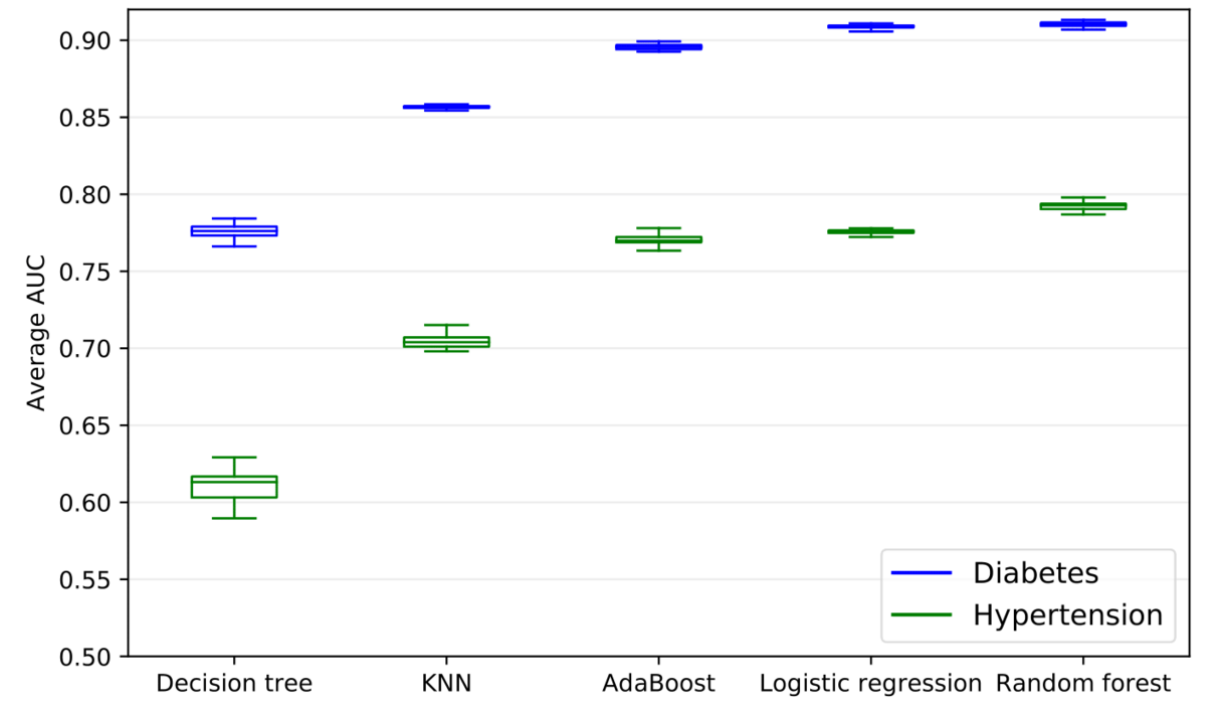
Figure 1. A comparison of area under the curve (AUC) distributions across 250 test sets between 5 risk stratification models for both diabetes and hypertension. The random forest model had the highest AUC for both diabetes (mean [SD], 0.910 [0.001]) and hypertension (mean [SD], 0.792 [0.002]). The upper and lower boundaries of the boxes correspond to the first and third quartiles, respectively. The line inside the box represents the median and the whiskers correspond to the minimum and the maximum of the distribution. KNN: K-nearest neighbors algorithm.